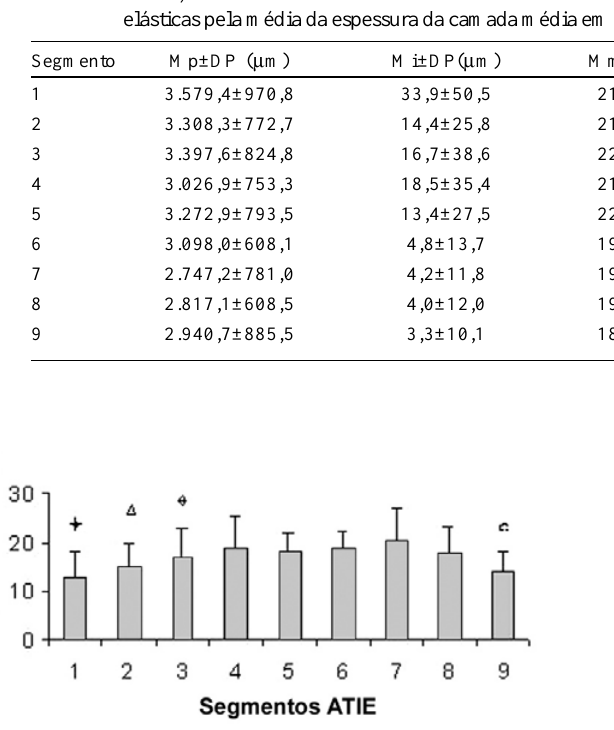
Fig. 6 - O número de lâminas elásticas apresenta maior concentração nos segmentos intermediários